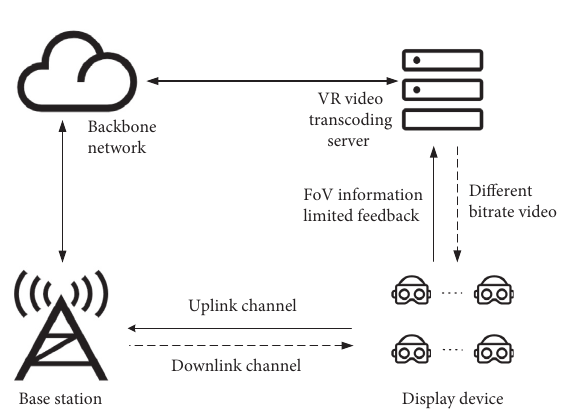
Figure 1: A typical scenario of a panoramic video streaming